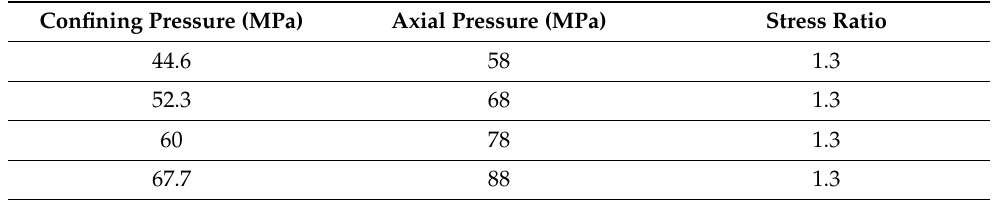
Table 3. 1-2-2 Sample experimental program. Table 3. 1 ‐ 2 ‐ 2 Sample experimental program. Confining Pressure